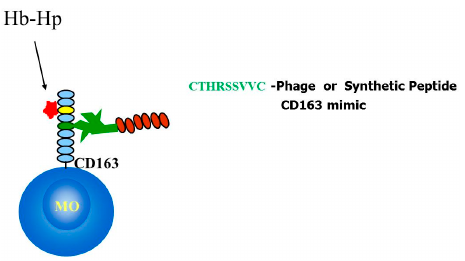
Figure 5 . YES Hypothesis in situ. Fifth Scavenger Receptor domain of CD163 probably is Figure 5. YES Hypothesis in situ. Fifth Scavenger Receptor domain of CD163 probably is pseudo-homodimer with CTHRSSVVC peptide (CD163-mimic). pseudo-homodimer with CTHRSSVVC peptide (CD163-mimic). 2.5. CTHRSSVVC-Phage Is Internalized by CD163 Expressing Cells